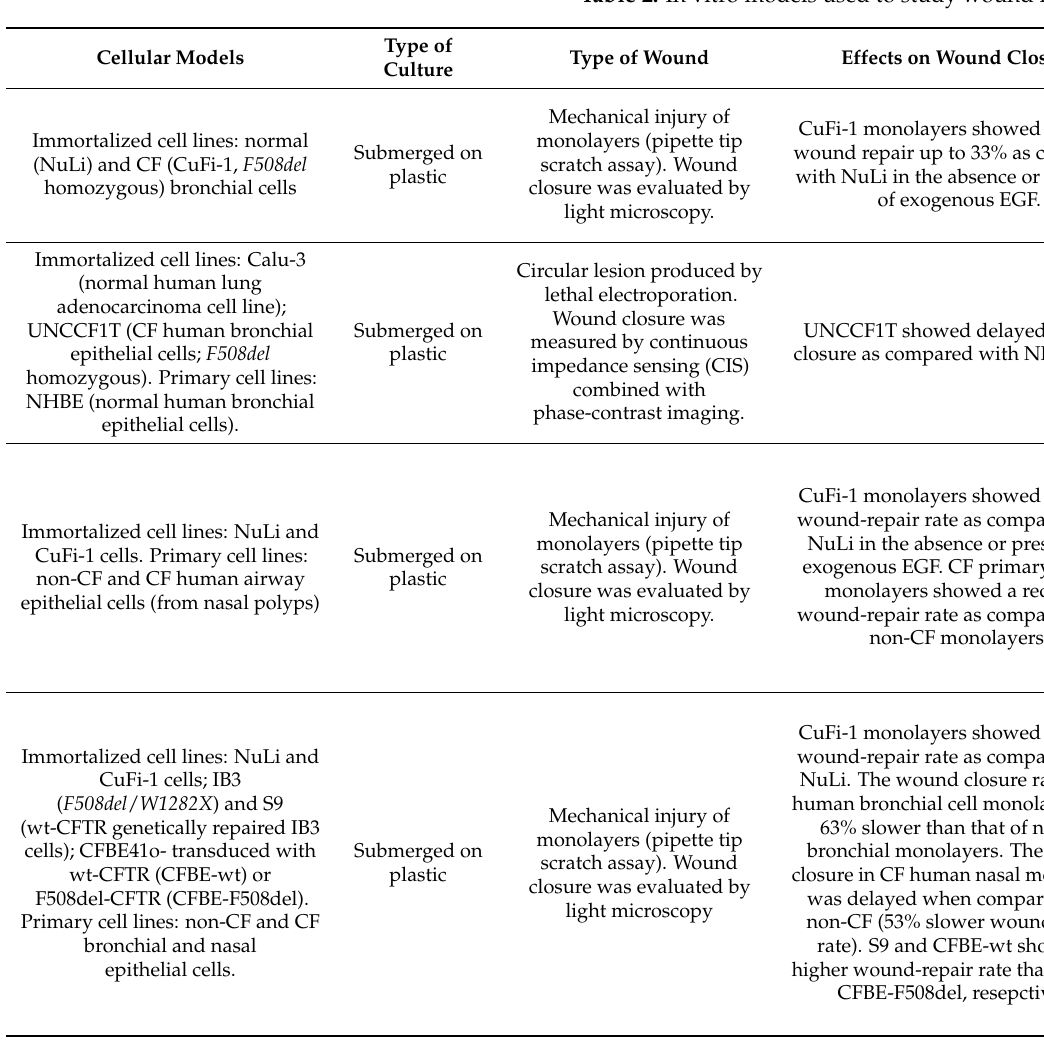
Table 2. In vitro models used to study wound repair and its modulation in